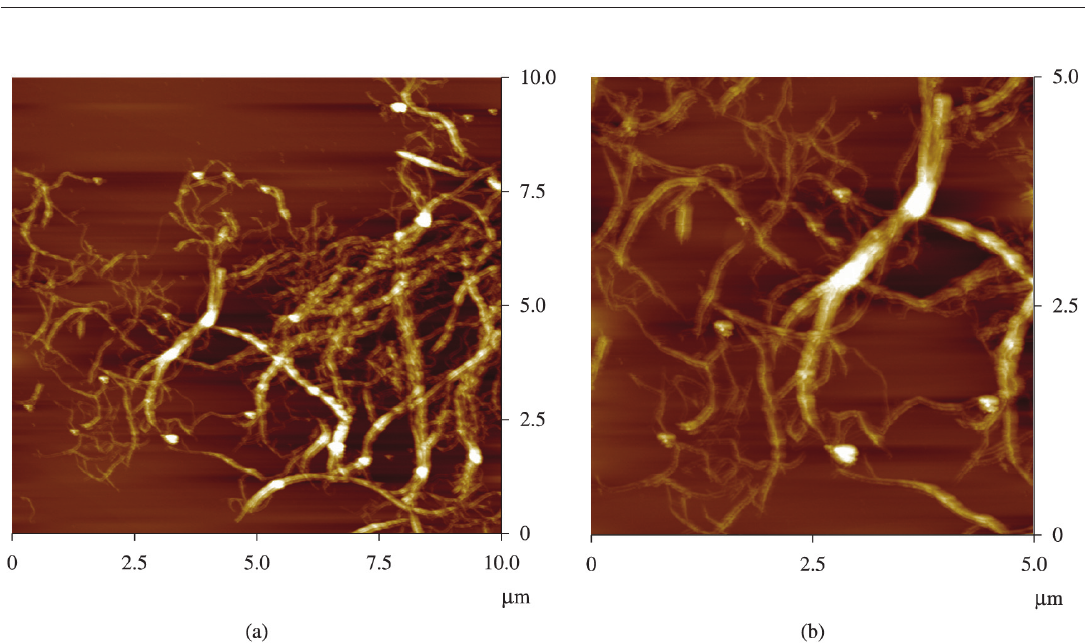
Figure 1. AFM height images cellulose microfibrils on mica substrate, (a) 10 × 10 mm and (b) and 5 × 5